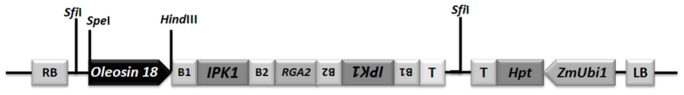
Schematic diagram showing partial map of RNAi vector construct.pOle18-IPK1-006 vector construct showing the IPK1 gene cloned in sense and antisense orientation separated by wheat RGA2 intron. HPT gene was used as the plant selection marker. (T = CaMV 35S terminator).